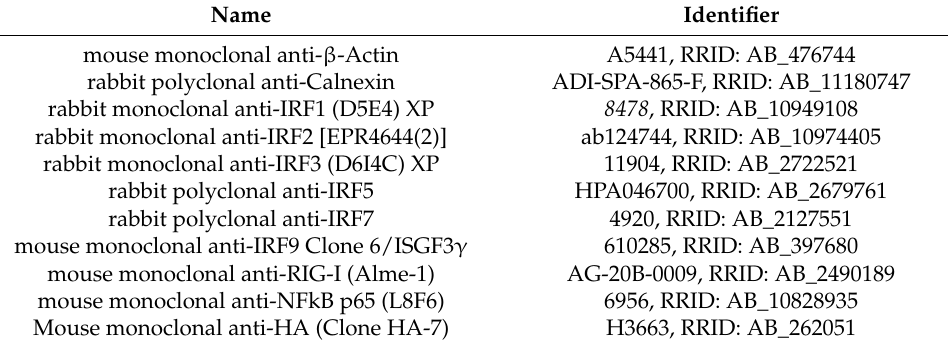
Table 2. Primary Antibodies used for Immunoblotting (1:1000 dilution).